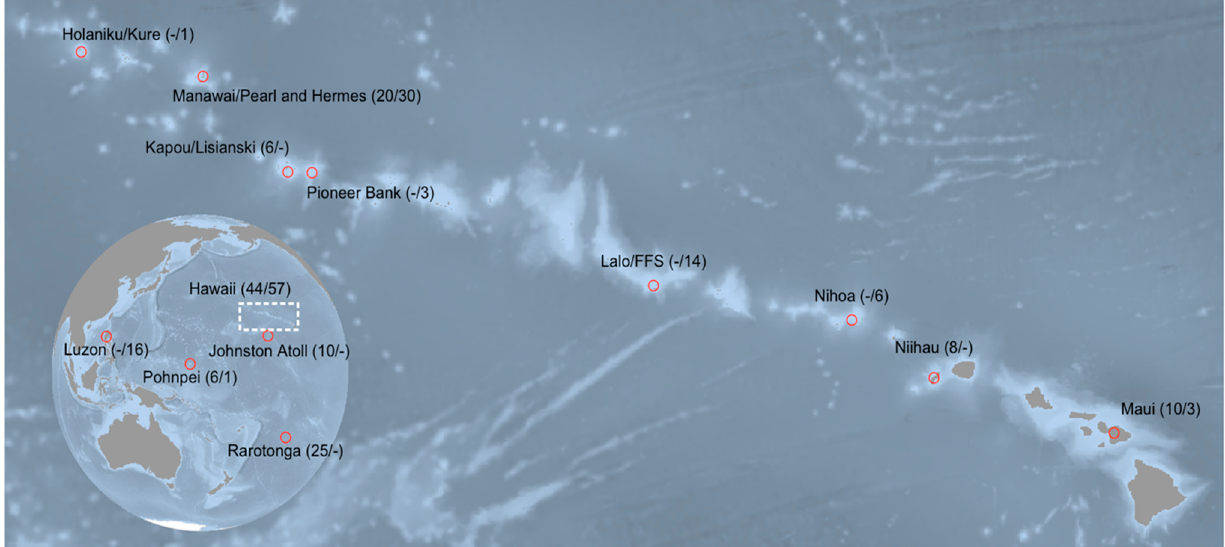
Figure 1. Bathymetric map of sampling locations and number of specimens taken per site for Myripristis chryseres and Neoniphon aurolineatus ( M. chryseres / N. aurolineatus ). Main map indicates sampling sites in the Hawaiian Archipelago, inset indicates additional sample sites in the Central and West Pacific.